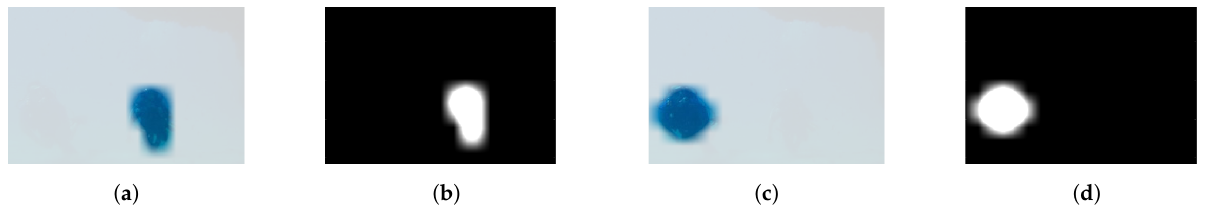
Figure 4. Example of attended locations computed from the original image depicted in Figure 3: ( a ) attended location deriving from center-surround operations on intensity between scales σ = 3,6 and ( b ) corresponding attended mask; ( c ) attended location deriving from center-surround operations on intensity between scales σ = 4,7 and ( d ) corresponding attended